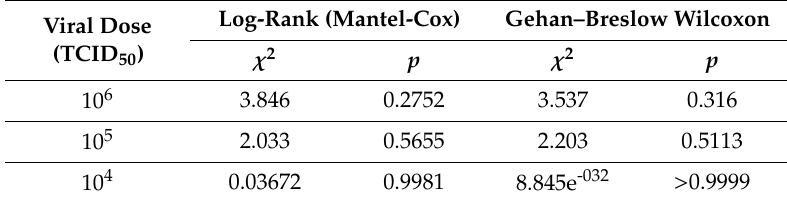
Table 1. Chicken embryo mortality rates comparison following the infection with three di ff erent doses of four Usutu virus strains and using log-rank (Mantel-Cox) and Gehan-Breslow Wilcoxon tests.